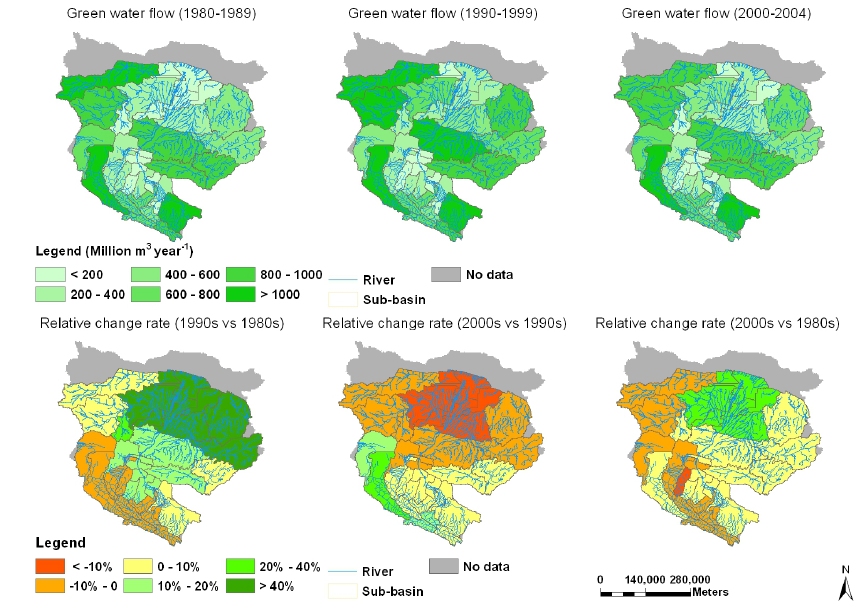
Fig. 7. The green water flows (the best simulation and long term average annual values) (million m 3 yr − 1 ) from the 1980s to the 2000s in the Heihe river basin.